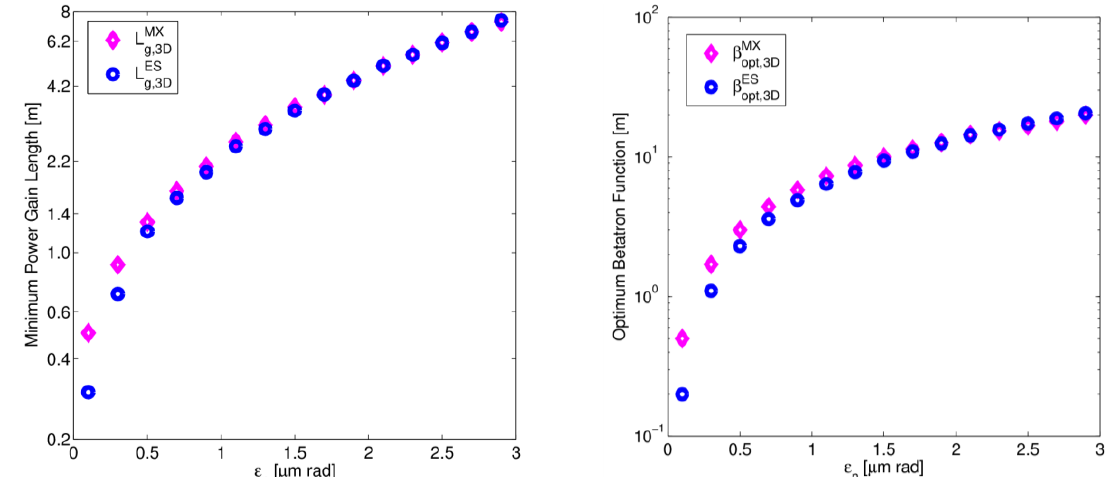
Figure 3. Minimum 3-D power gain length ( left ) and optimum betatron function ( right ) as function of the slice rms energy spread at the undulator, for the M. Xie (circles) and E. Saldin et al. (dots) formulas.